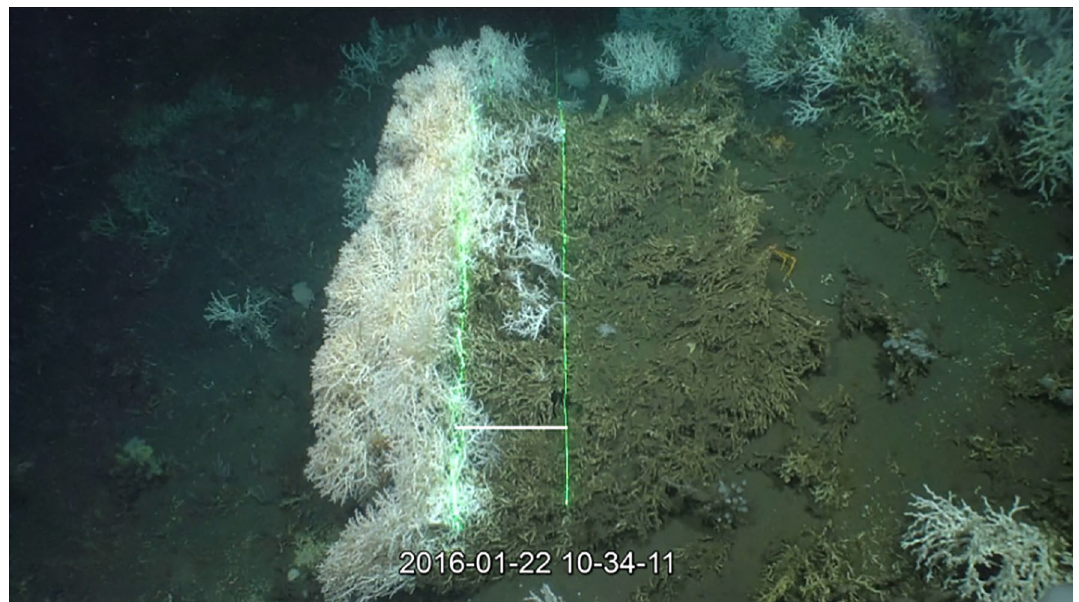
Figure 3. Scaling of large Madrepora oculata framework (Scary mound, Angola). The ROV used for video surveys was equipped with two line lasers. The parallel green lines are the projected laser beams, which are 30 cm apart (the distance between the beams is depicted by a white line) and are used as a scale. Credits: photograph by MARUM ROV